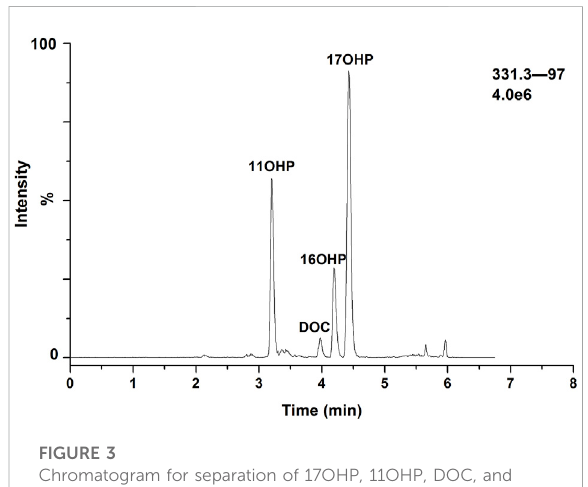
FIGURE 3 Chromatogram for separation of 17OHP, 11OHP, DOC, and